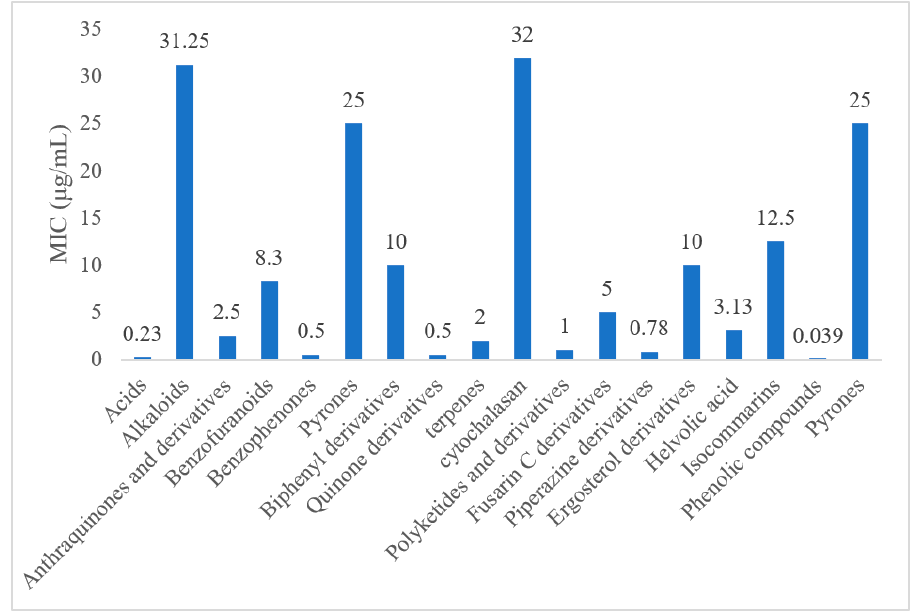
Figure 4. Major chemical classes with the lowest MIC values against gram-negative bacteria. As shown in Table 2 below, we list the MIC values of the main antimicrobial agents used in clinical practice against some of the gram-negative bacterial families. Table 2. MIC values of the main commercially known antimicrobial agents. Adapted from Clinical and Laboratory Standards Institute (CSLI) [126].